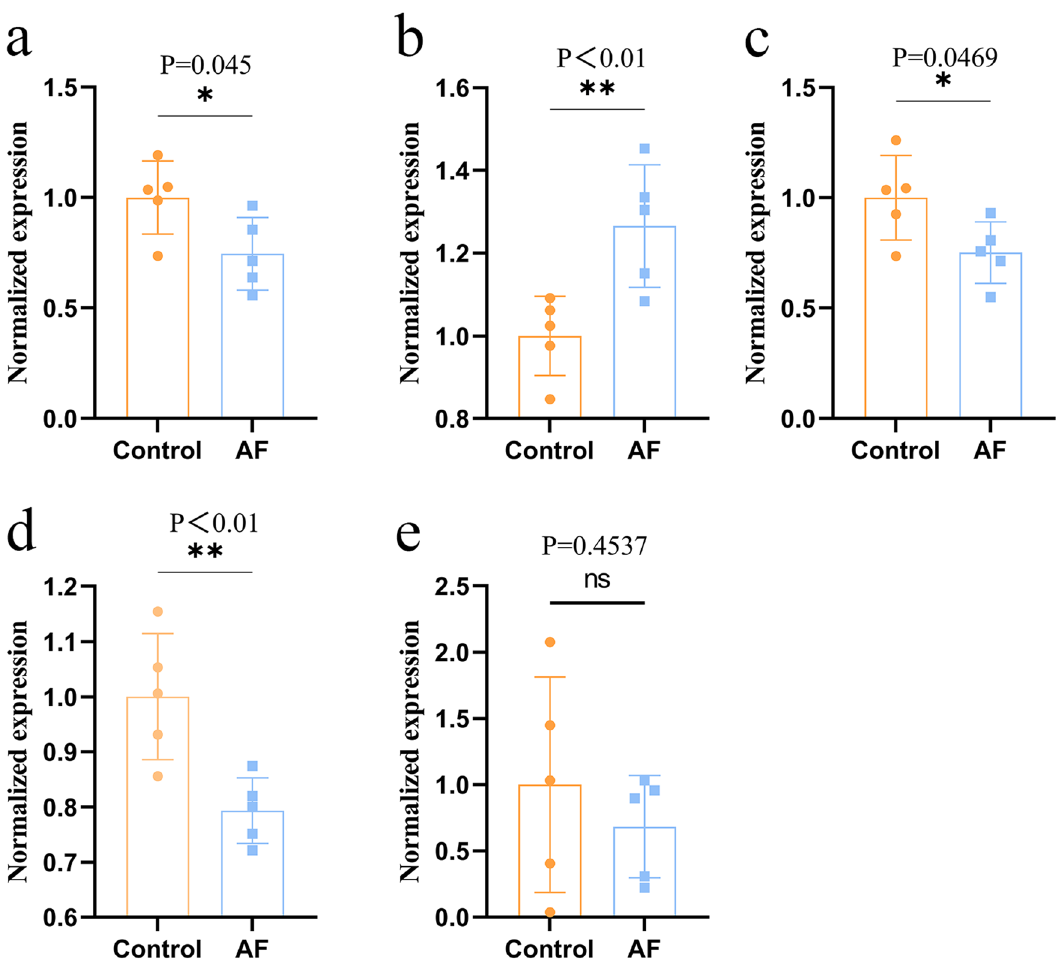
Figure 7. The core action targets of Que on AF were differentially expressed in the GEO data set. Left atrial healthy controls n = 5, AF group n = 5. Values are expressed as mean ± SD. Compared with Control, *P < 0.05 and **P < 0.01. ( a ) IL-6 differential expression; ( b ) VEGFA differential expression; ( c ) JUN differential expression; ( d ) EGFR differential expression; ( e ) MMP9 differential